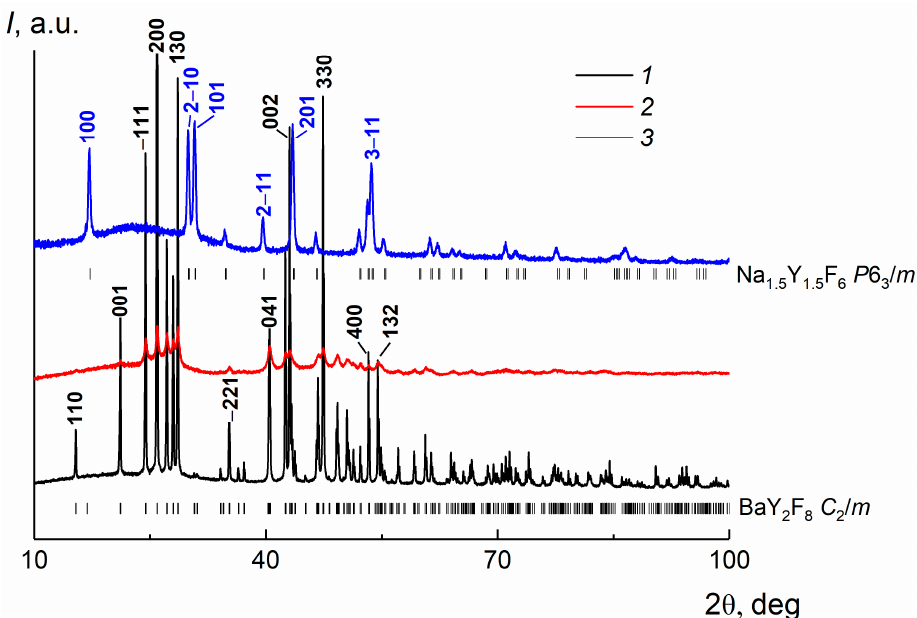
Figure 2. XRD patterns of a bulk Ba(Y 0.964 Yb 0.030 Er 0.006 ) 2 F 8 crystal ( 1 ), Ba(Y 0.964 Yb 0.030 Er 0.006 ) 2 F 8 particles, produced by milling procedure ( 2 ), β -Na 1.5 (Y 1.17 Yb 0.3 Er 0.03 )F 6 NPs, synthesized by thermolysis ( 3 ). The positions of the Bragg reflection peaks for the specified space groups are indicated. Table 1. Calculated unit cell parameters for a bulk Ba(Y 0.964 Yb 0.030 Er 0.006 ) 2 F 8 crystal and nanodisper- gated particles and β -Na 1.5 (Y 1.17 Yb 0.3 Er 0.03 )F 6 NPs, synthesized by thermolysis. Space